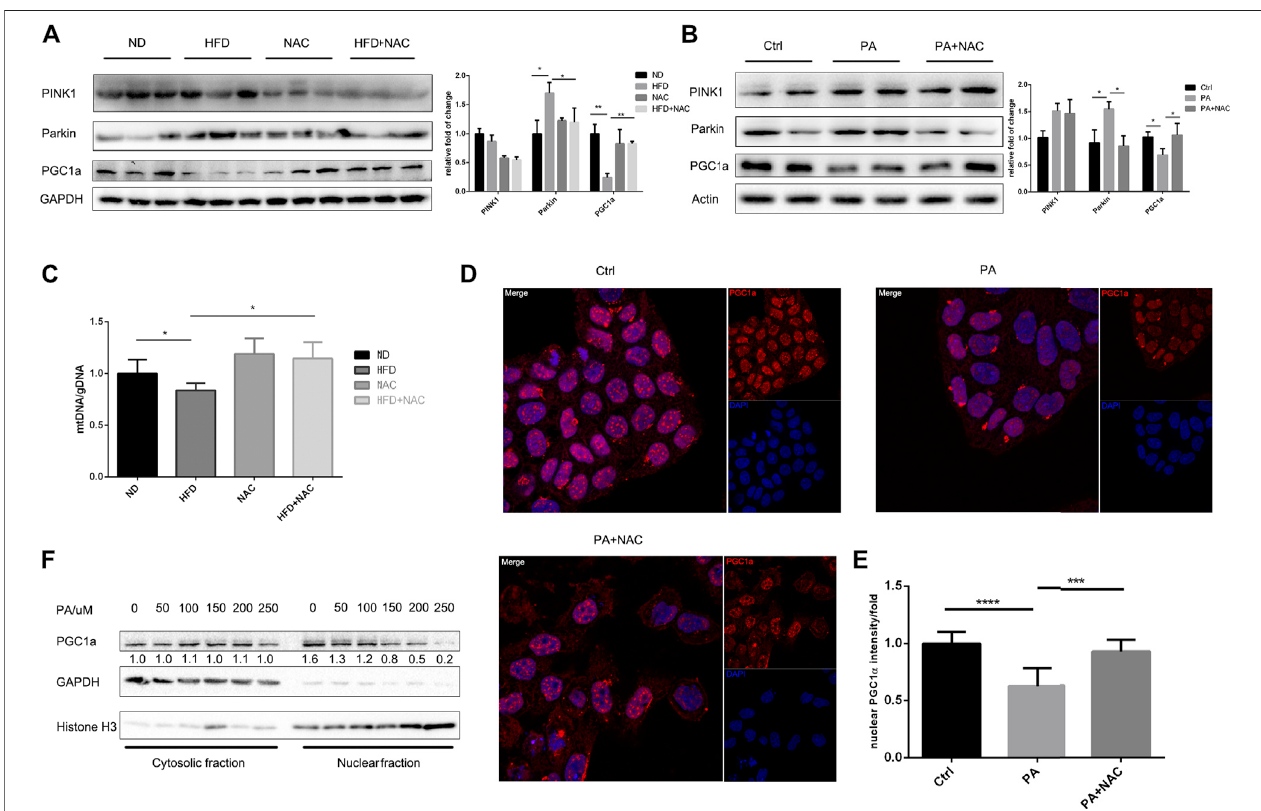
FIGURE 3 | NAC treatment inhibits PA-induced mitophagy and promoted mitochondria biogenesis via PGC1a. (A,B) Representative Western blot image of mice hepatic tissue (A) and LO2 cell (B) revealed protein level of mitophagy initiating protein PINK1 and Parkin and mitochondria biogenesis key protein PGC1a. The experiment was conducted triple; (C) mitochondrial gDNA copy number in a different group of mice liver; (D) immuno fl uorescence of PGC1a revealed different subcellular localization, scale bar was 10 μ m, and the nuclear PGC1a fl uorescence intensity was analyzed in (E) ; (F) separation of nuclear and cytosolic protein underdifferentconcentrationofPAstimulationand protein levelofPGC1a measuredbyWesternblot(* p < 0.05, *** p < 0.001,and **** p < 0.0001; allthe datasigni fi cance was analyzed by